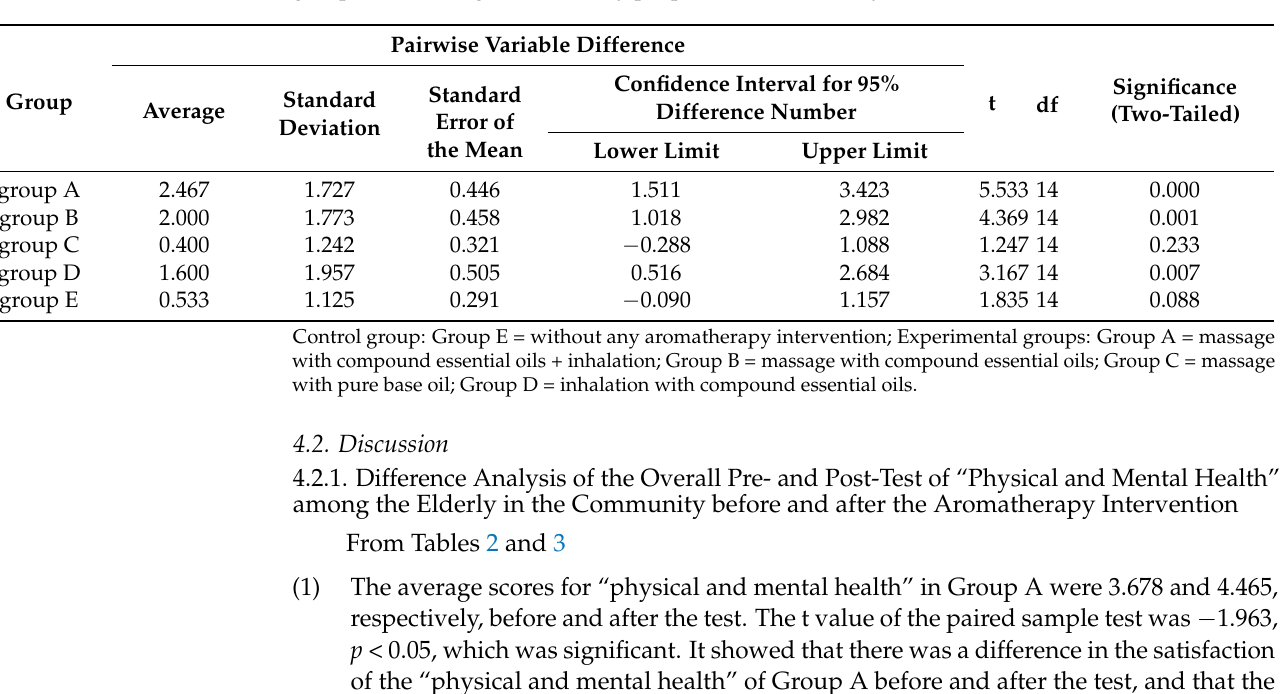
Table 5. Sample t -test checklist for pre- and post-test dependent samples of “stress” in the same group of middle-aged and elderly people in the